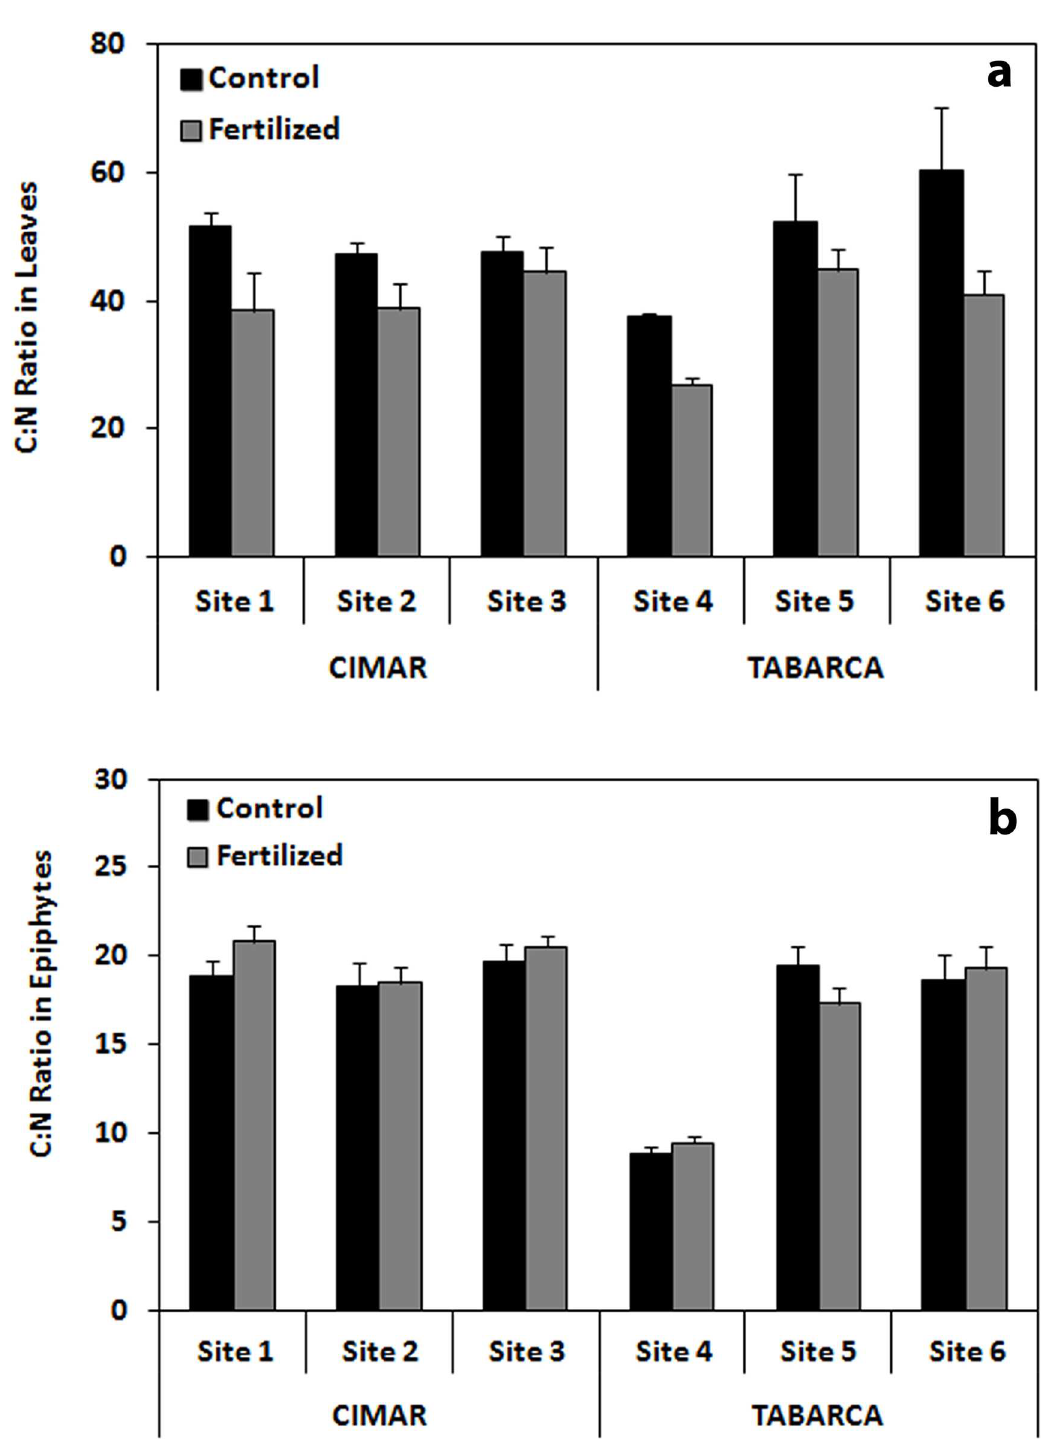
Fig 2. C:N ratio recorded in leaves(a) and epiphytes (b) of P . oceanica at CIMAR and Tabarca in the different sites for control vs. fertilized treatments. Mean ± SE.